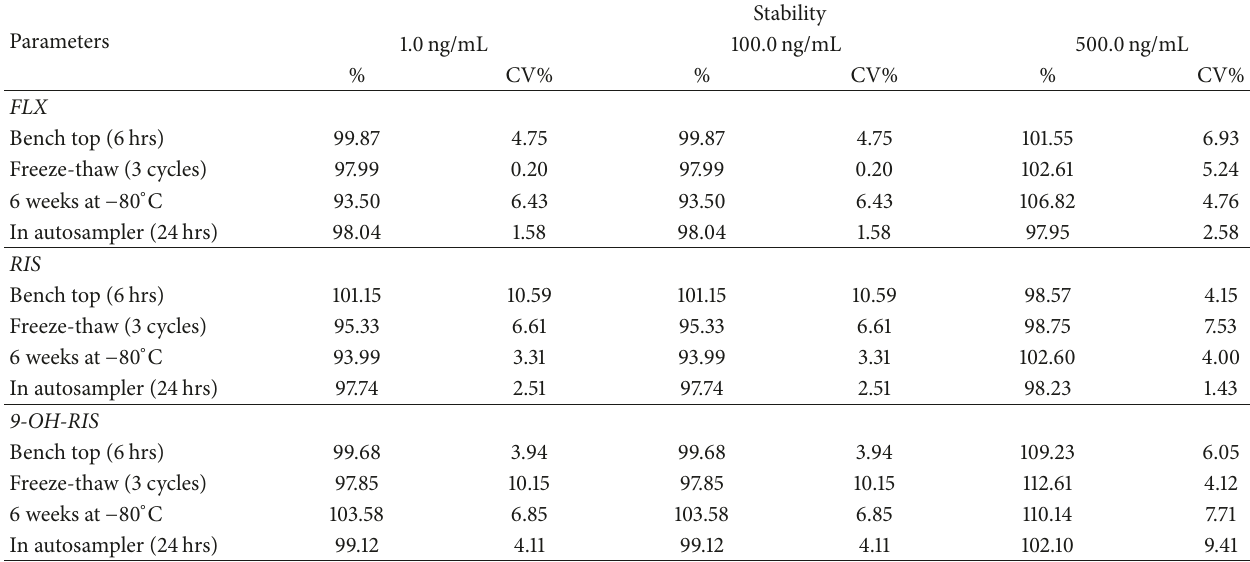
Table 4: Data showing the stability of FLX, RIS, and 9-OH-RIS in human rat plasma at different QC levels ( 𝑛 = 6).